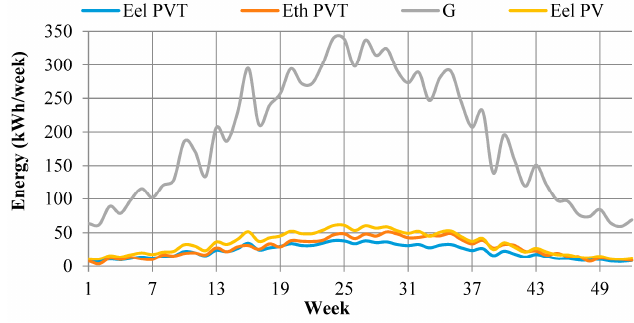
Figure 6. Weekly energy trends.